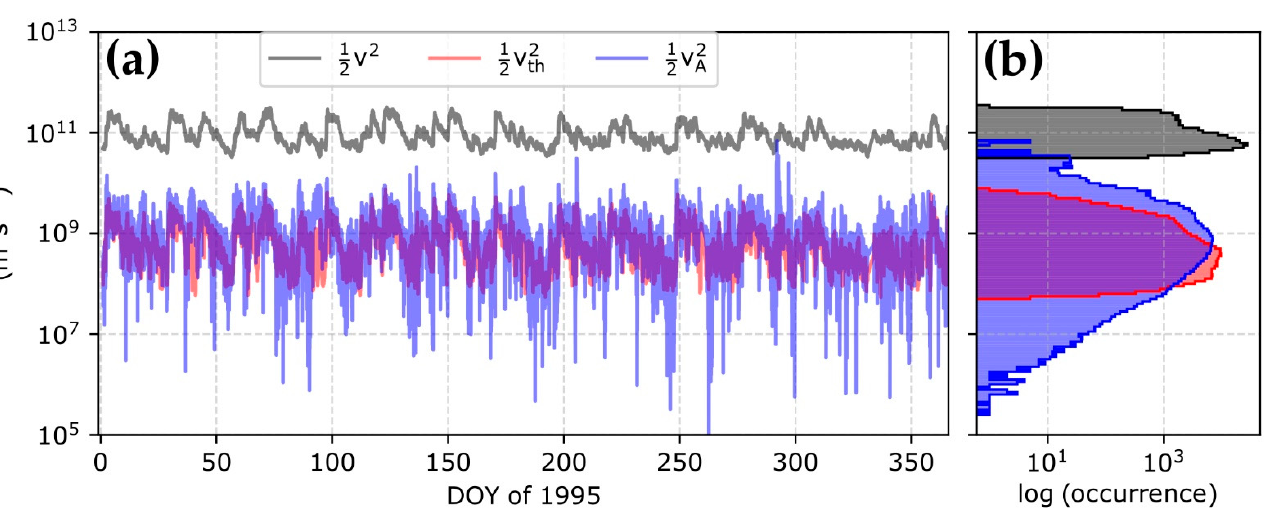
Figure 1. ( a ) The (gray) 1 ( b ) the corresponding histograms of each term. The dynamic term 1